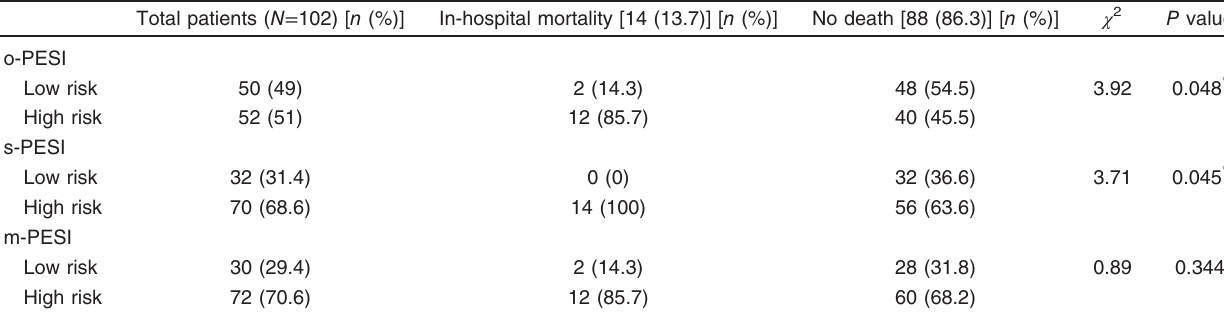
Table 3 Frequency of in-hospital death according to risk stratification of the studied scores Total patients ( N = 102) [ n (%)]